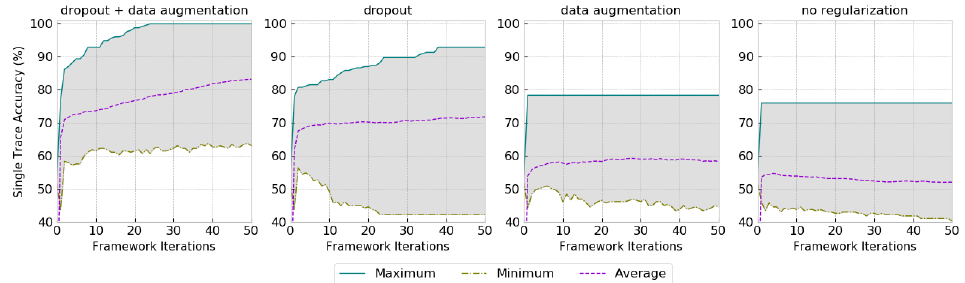
Figure 7: Minimum, maximum, and average single trace accuracy with iterative framework on the cswap-arith dataset.